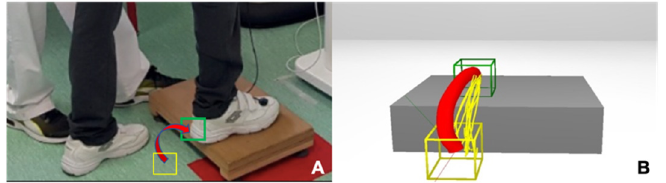
Figure 1. Representations of the task in the real and virtual stage. ( A ) Real scenario (raising the foot to a step); ( B ) virtual scenario that the patient could view on the screen. The red line represents the ideal trajectory, whereas the yellow lines indicate the patients’ trajectory in the different trials. Simultaneous visual-auditory feedback was provided to the patients during the execution of the movements. In addition, the physiotherapist provided feedback to the patients to enhance their performance.